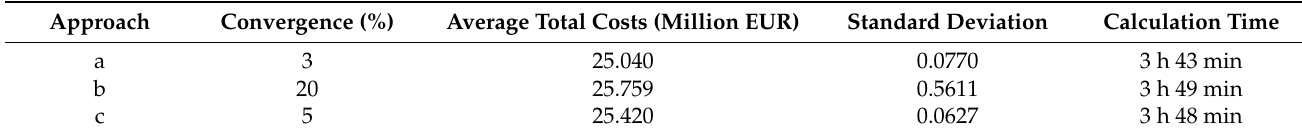
Table 2. Computational results and convergence